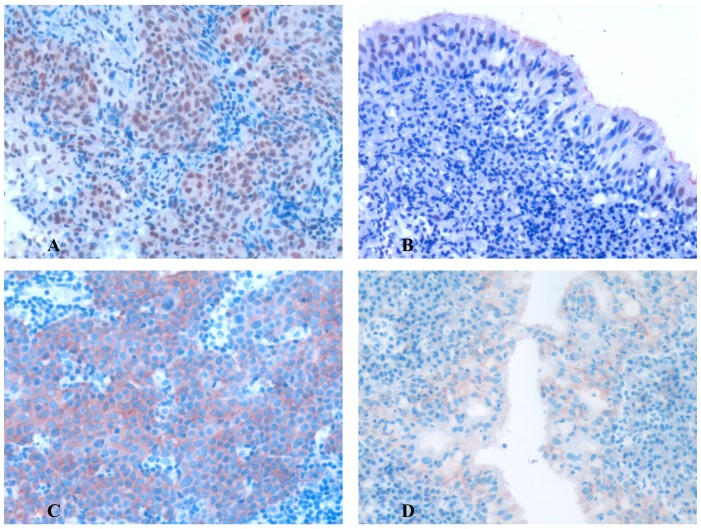
Expression of p-Mnk1 and p-eIF4E protein in NPC and non-cancerous nasopharyngeal epithelial tissues was detected by immunohistochemistry.The expression of p-Mnk1 and p-eIF4E protein was detected by immunohistochemistry using specific antibodies as described in the section of materials and methods. Strong positive expression of p-Mnk1 was found in nuclei of NPC (Fig. 1A, 20×, IHC, AEC staining). Low and weak nuclear positive expression of p-Mnk1 was showed in the non-cancerous nasopharyngeal epithelial cells (Fig. 1B, 20×, IHC, AEC staining). Strong positive expression of p-eIF4E in the cytoplasm of NPC (Fig. 1C, 20×, IHC, AEC staining). Weak positive expression of p-eIF4E in the cytoplasm of the non-cancerous nasopharyngeal epithelial cells (Fig. 1D, 20×, IHC, AEC staining).